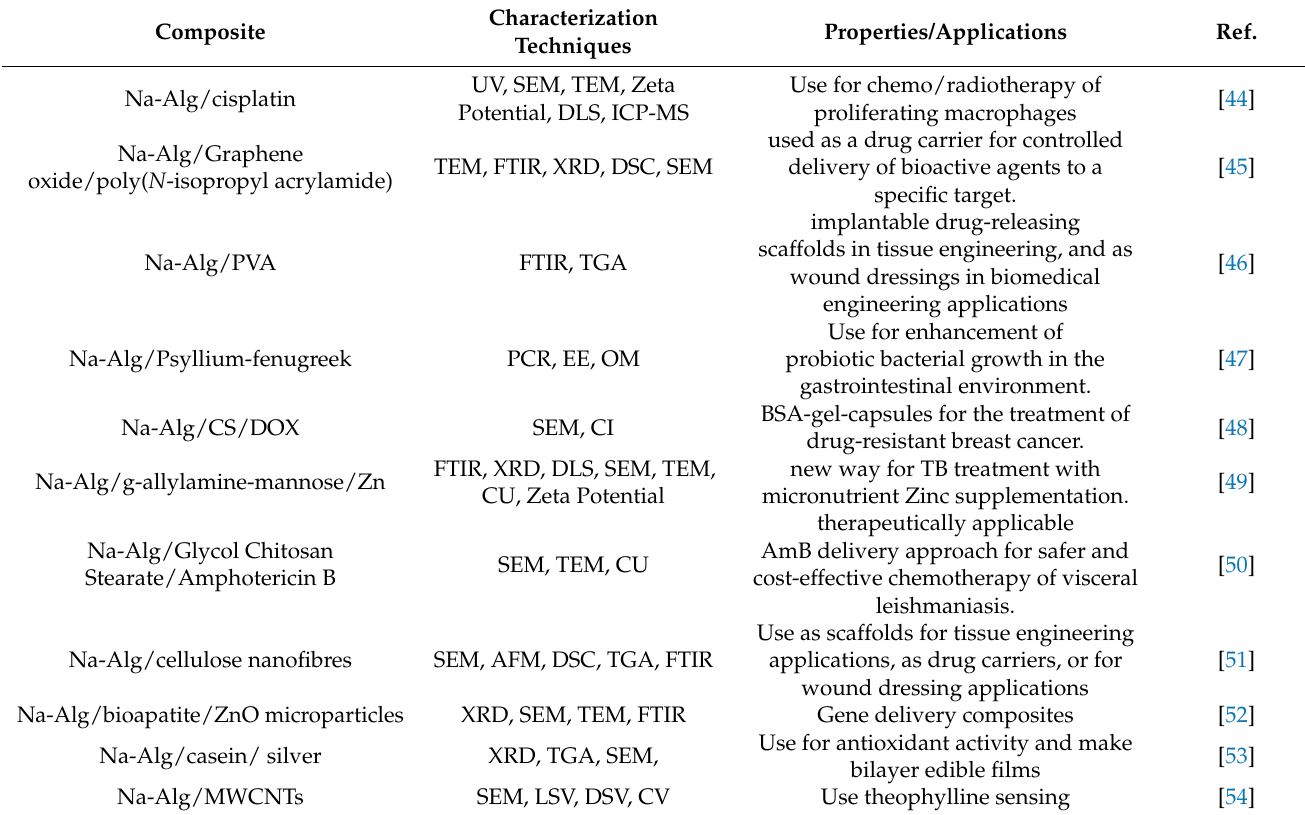
Table 1. Main applications in medicine for sodium alginate